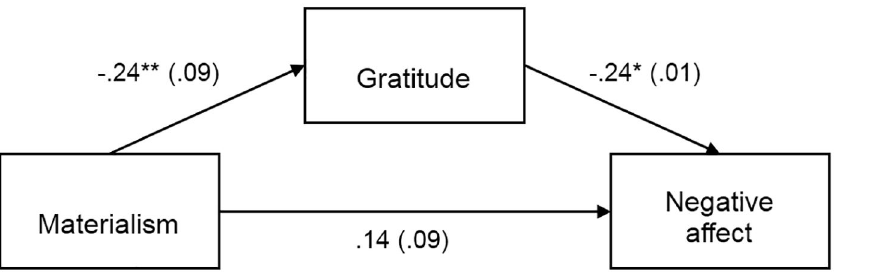
Figure 4. Materialism indirectly predicts negative affect through its relationship with gratitude, b = .06, SE = .04, 95% CI [.01, .16]. Unstandardized coefficients shown with standard error in parentheses. * p < .05. ** p <